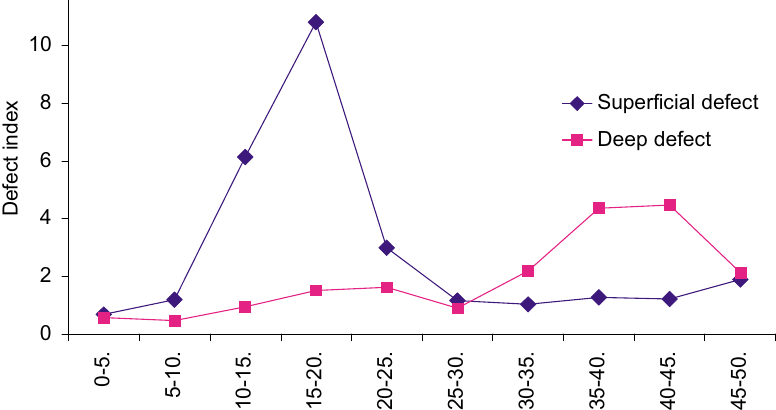
Fig. 8. Comparison between the Damage Index computed, starting from numerical data of the aluminium plate, for a superficial and a deep defect